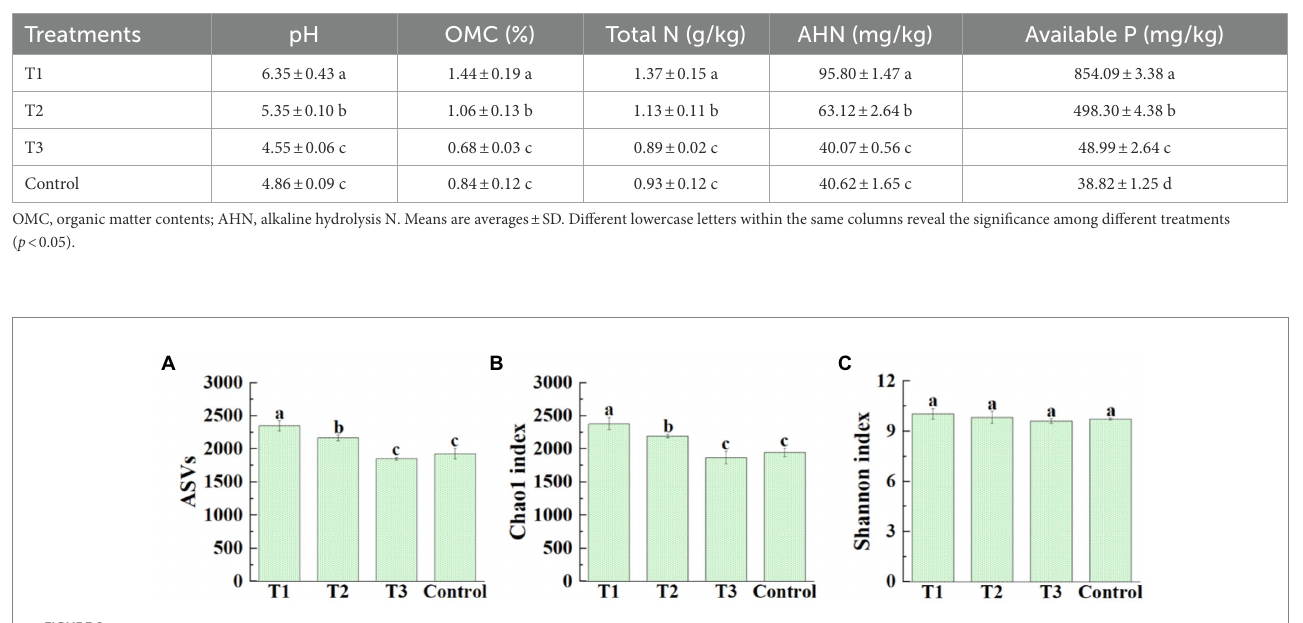
FIGURE 2 Effect of MF-HZ23 on the ASVs distribution (A) , Chao1 richness index (B) , and Shannon ′ s diversity index (C) of bacteria in pakchoi rhizosphere soil. T1: MF- HZ23 at 3.00 kg/m 2 ; T2: MF-HZ23 at 3.00 kg/m 2 plus CCF at 0.02 kg/m 2 ; T3: CCF at 0.04 kg/m 2 ; T4: control. Different lower case letters above columns indicate statistical differences ( p <